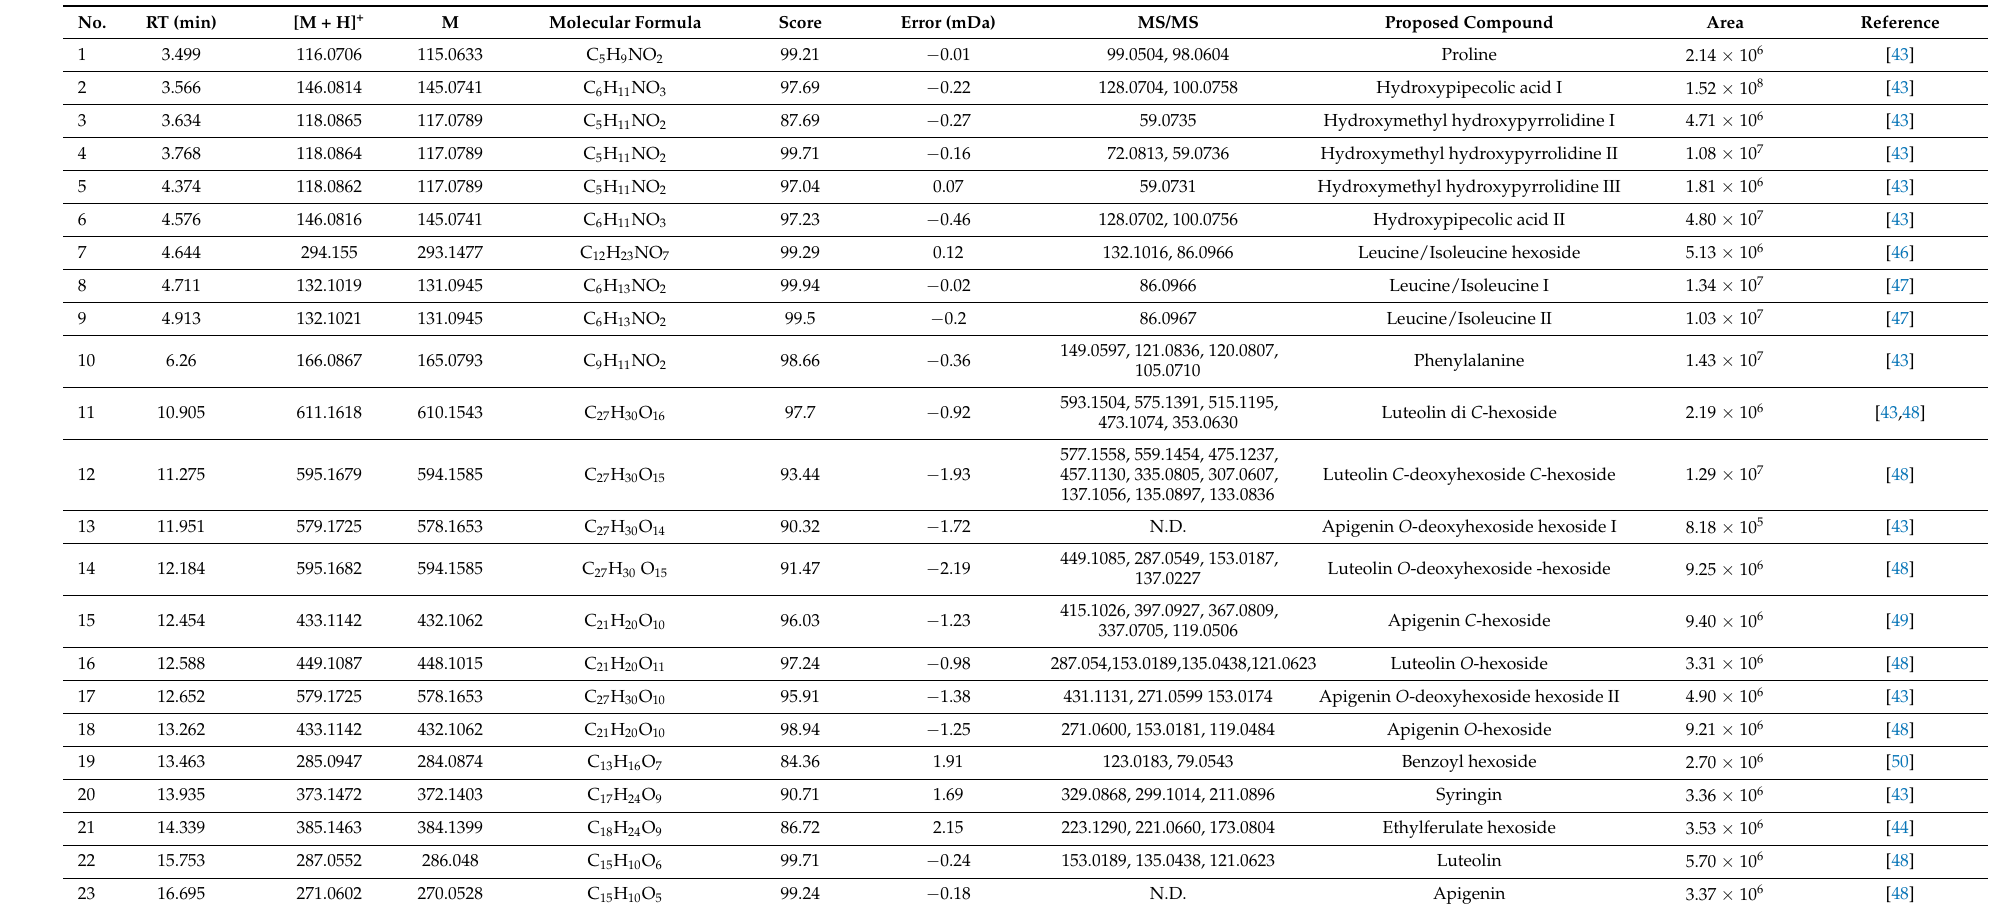
Table 6. Metabolite profiling of CRB via UPLC-ESI-QTOF-MS in positive